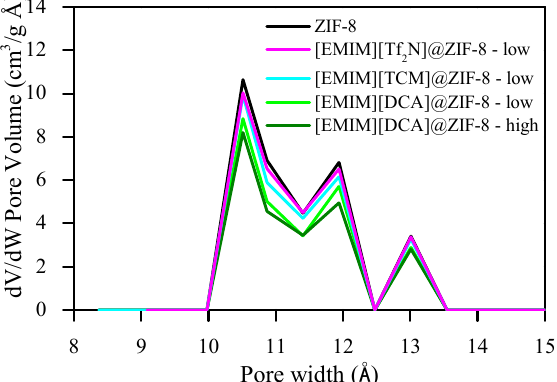
Figure A7. Pore Size Distribution (PSD) of ZIF-8 and IL@ZIF-8 composites.